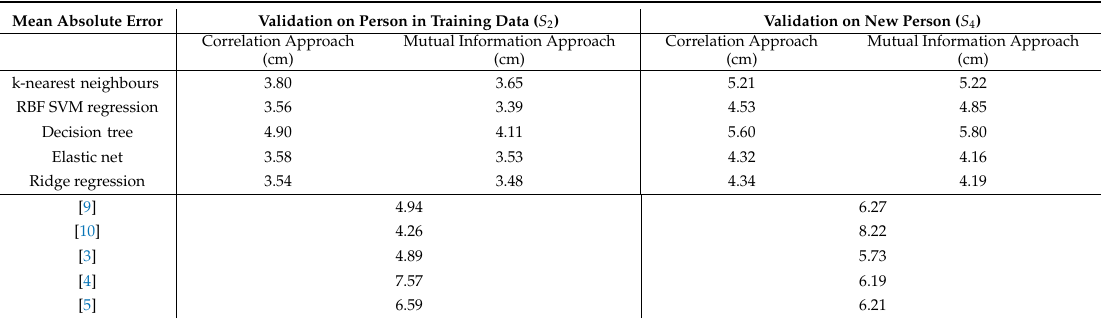
Table 5. Accuracy comparison of different machine learning algorithms and approaches with two neural network step length algorithms and three parametric approaches , validated on new data of a test person that was used for training and new data of a new test